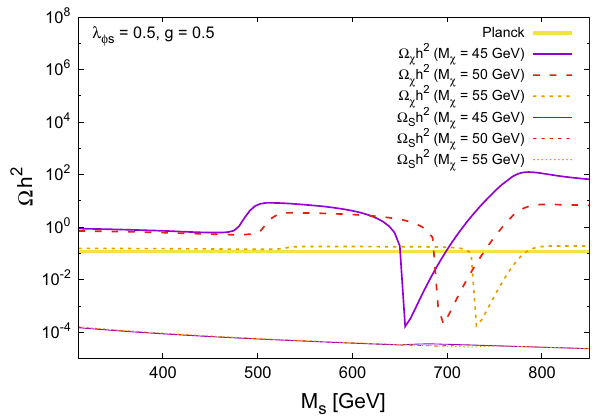
Fig. 4 Relic density as a function of the scalar DM mass for different values of the fermionic mass M χ